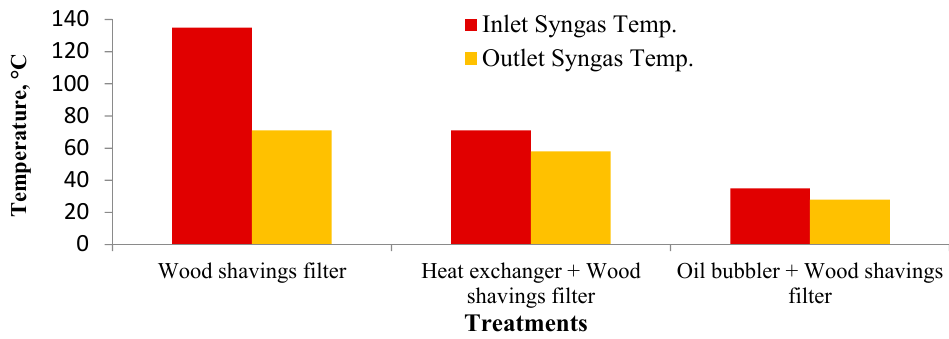
Figure 10. Syngas temperature at the inlet and outlet of the wood shavings filter for the three treatments.